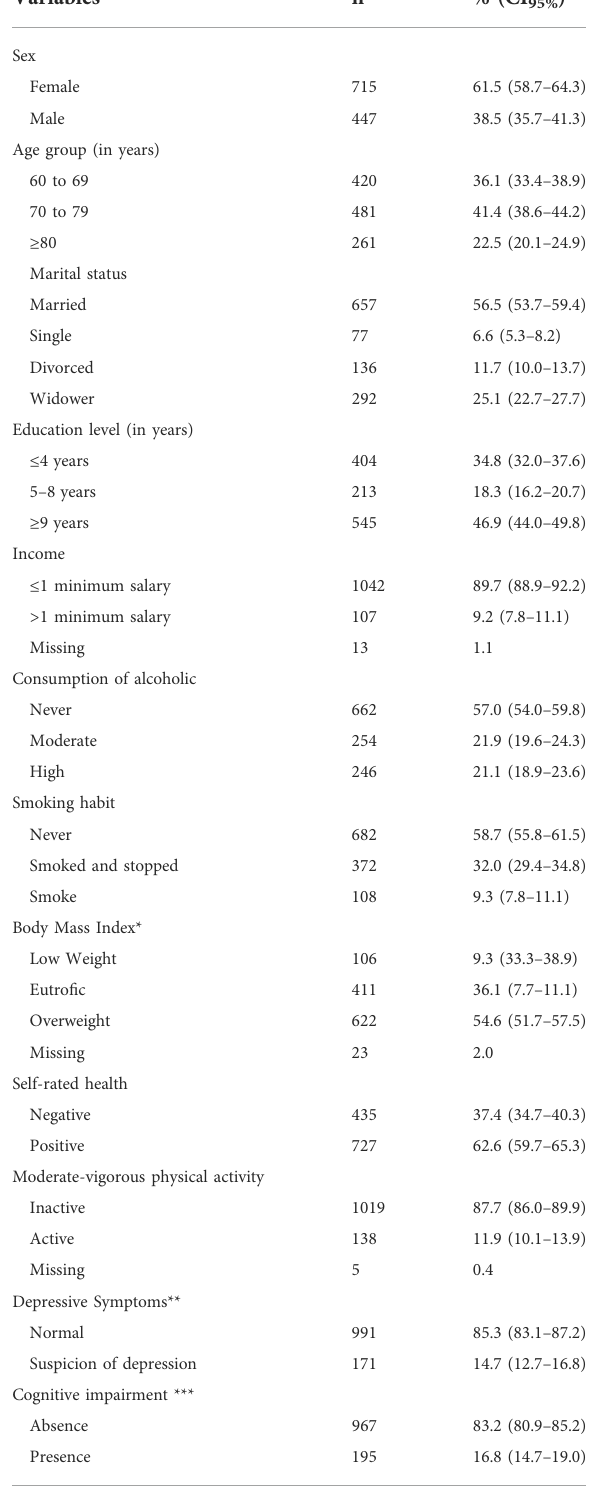
TABLE 1 Characteristics of the participants of the EpiFloripa Aging Study. Florianopolis, Brazil, 2017 – 2019 (n = 1,162).